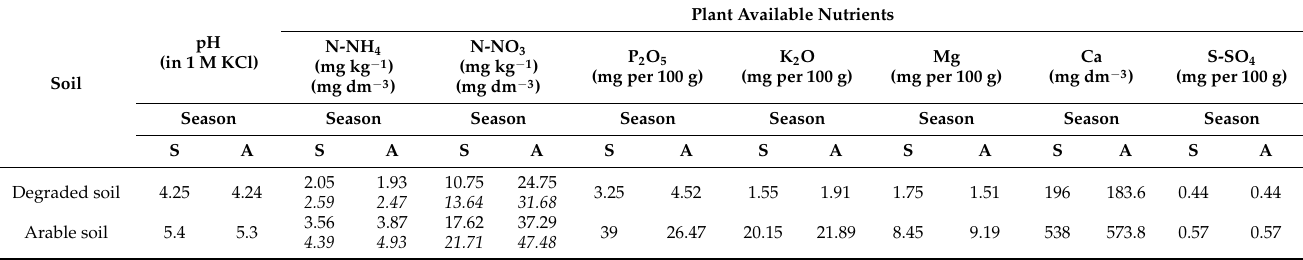
Table 1. Characteristics of soils used for plant cultivation.